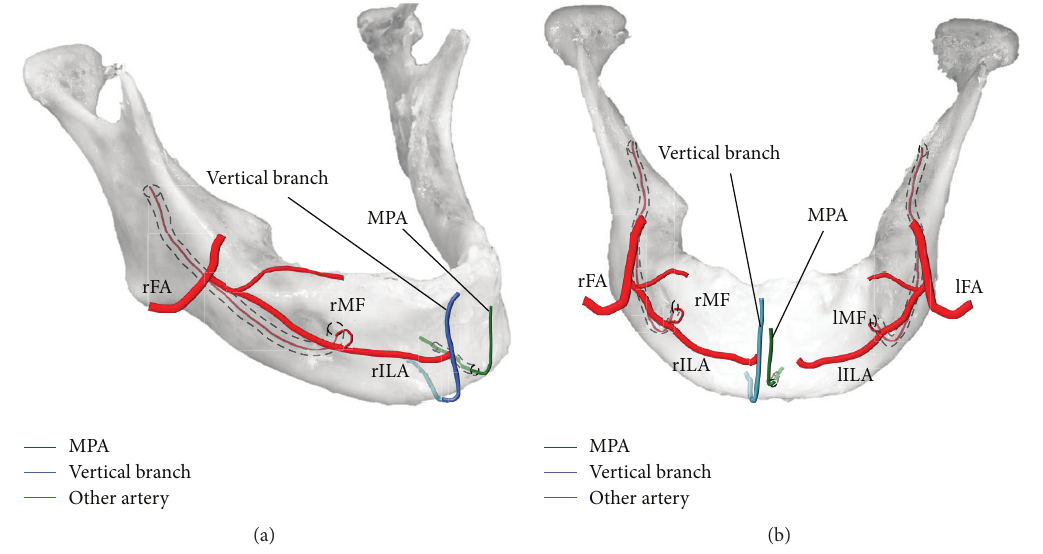
Figure 2: MPA (green line), vertical branch (blue line), and other arteries (red lines) are shown in lateral (a) and frontal (b) views. Both facial arteries branch off the inferior labial arteries (ILAs). Both ILAs anastomose with the mental arteries arising from the mental foramina. The right ILA anastomoses with the vertical branch coming from the inferior border of the mandible without perforating the mandible. The median perforating artery (MPA) comes from the posterior of the mandible and perforates the mandible. It then goes up to the inferior labial region. lFA, left facial artery; lILA, left inferior labial artery; lMF, left mental foramen; rFA, right facial artery; rILA, right inferior labial artery; rMF, right mental